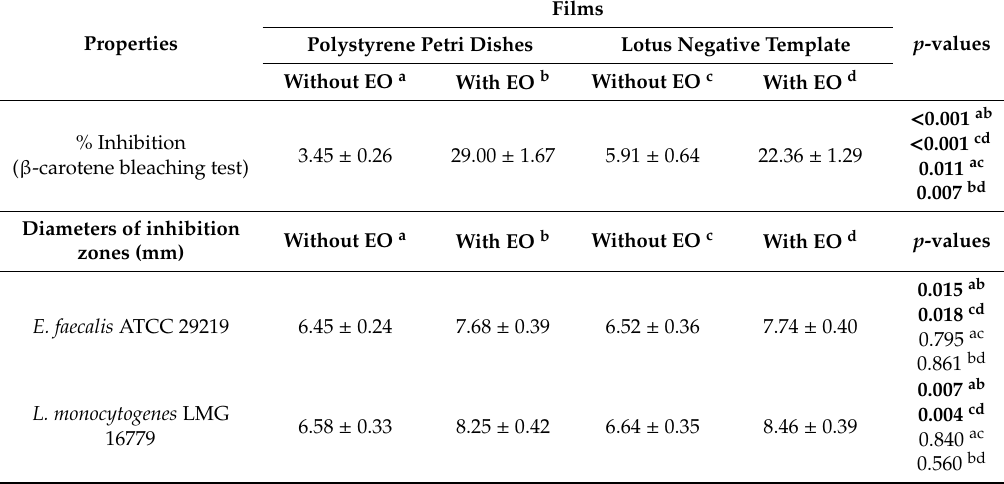
Figure 4. Antioxidant activity of the films measured by DPPH scavenging assay. Table 4. Antioxidant activity ( β -carotene bleaching assay) and diameters of inhibition zones obtained with the